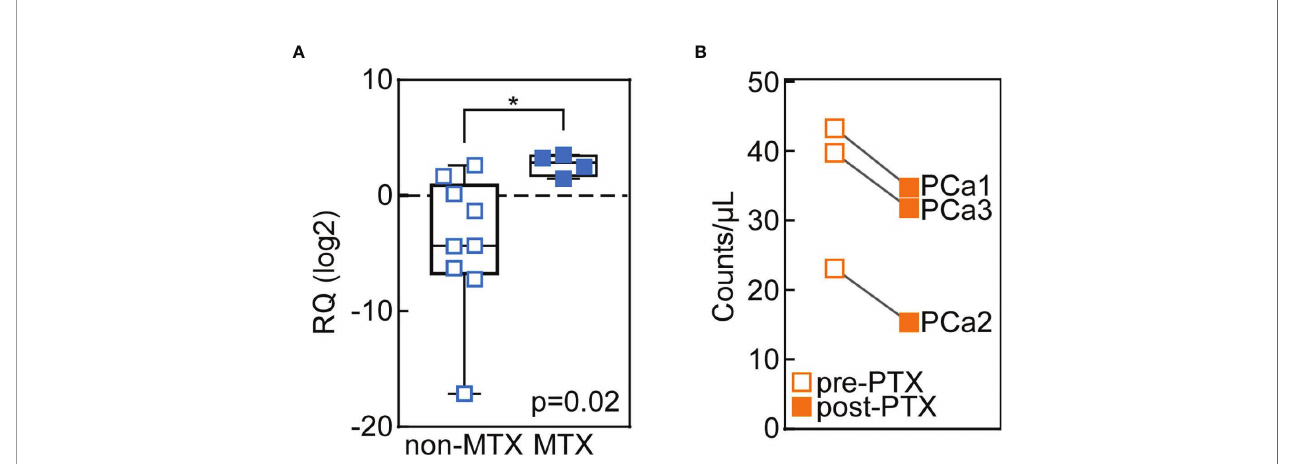
FIGURE 2 | BC200 is overexpressed in tissues from metastatic carcinomas and its circulating levels decrease after parathyroidectomy (PTX). (A) BC200 levels were analyzed through qRT-PCR in parathyroid tissues from non-metastatic (MTX) PCas (n=9; blank squares) and MTX metastatic PCas (n=4; full squares). Whiskers represent min to max values. *p=0.02 from Mann-Whitney U-test. (B) Circulating BC200 levels are reduced after PTX (full squares) in PCa patients. BC200 counts/µl were measured using dPCR in the serum of 3 PCa patients, of which pre- and post-PTX samples were